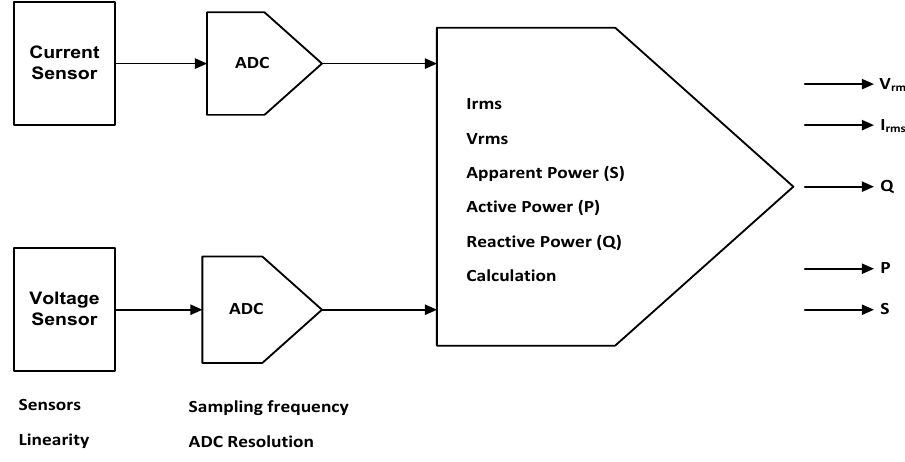
Figure 9. Block diagram of the power measurement